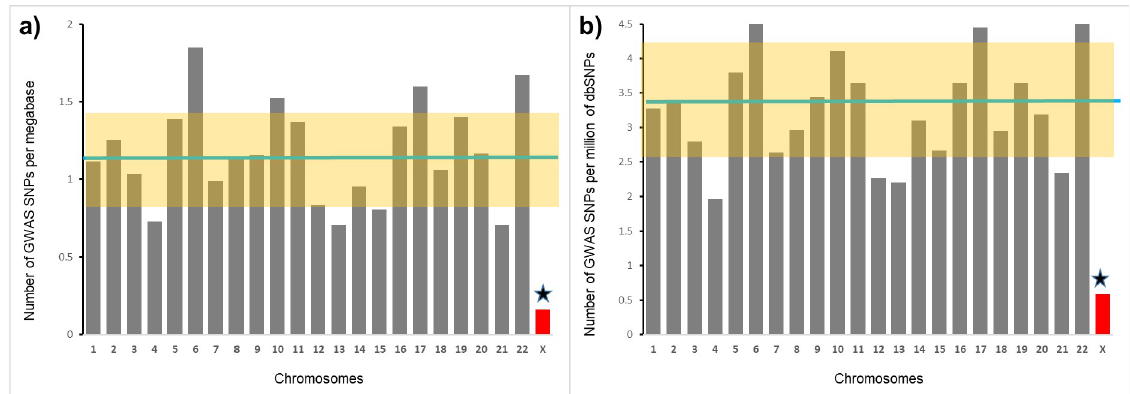
Fig 5. A comparison of X-chromosome and autosomes by the density of GWAS-detected SNPs in the female-only GWASs. The green horizontal line is the average among all autosomes; the highlighted area represents SD for autosomes; star marks a significant difference between X-chromosome and the average for autosomes. (a) The number of female-restricted GWAS-detected SNPs per megabase. (b) The number of female-restricted GWAS-detected SNPs per million of SNPs reported by dbSNP database for a given